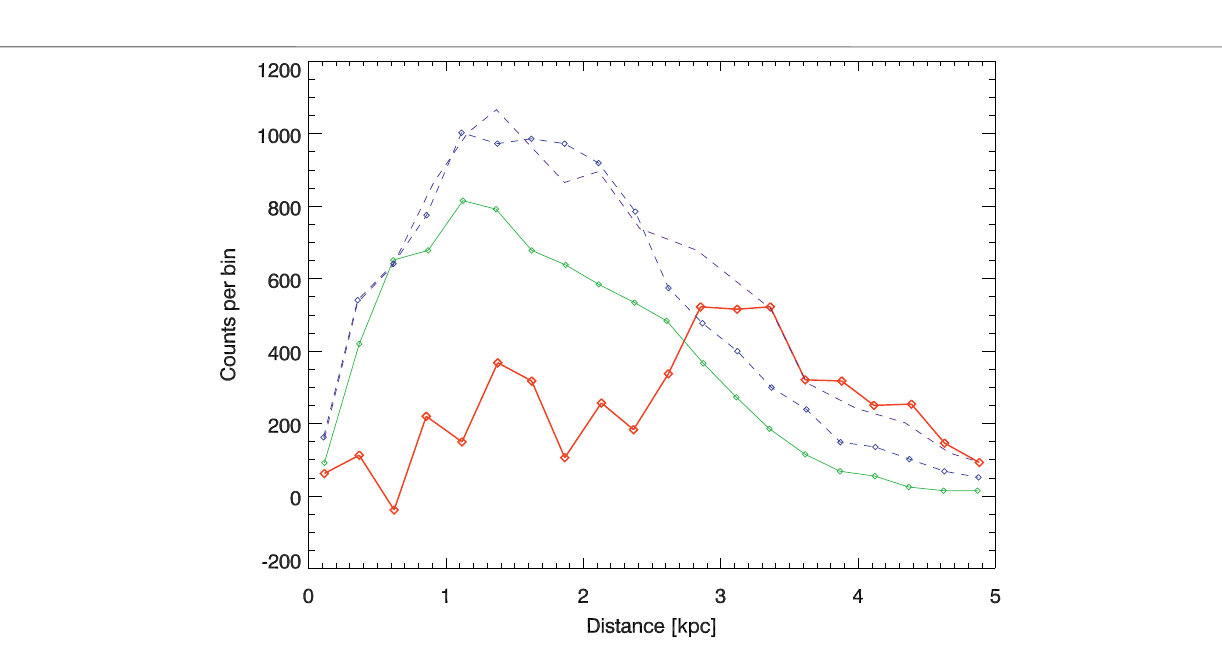
Frontiers in Astronomy and Space Sciences |